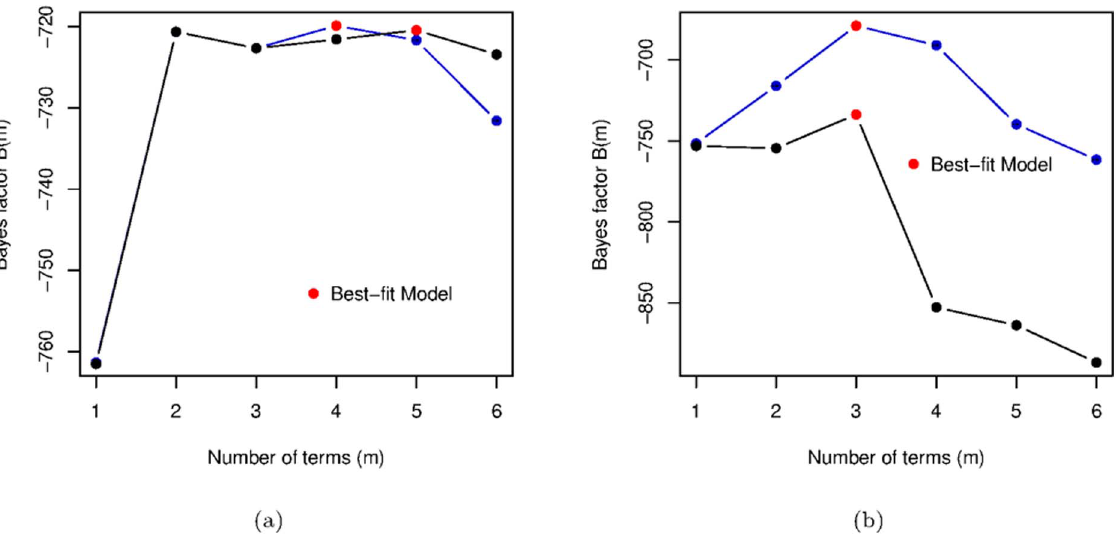
Figure 6. Choosing the best models. (a) Bayes factors for the two-variable dD models (black) and for the three-variable dD models (violet). The two red marked models refer to equation 8 and equation 12. (b) Bayes factors for the two-variable dG models (black) and for the three-variable dG models (violet). The two red marked models refer to equation 9 and equation 13. In both cases, the Bayes factor for the two and three variable models are calculated over the same subset of data, which is (necessarily) one year shorter than that used in Fig. 2 and Fig. 4.